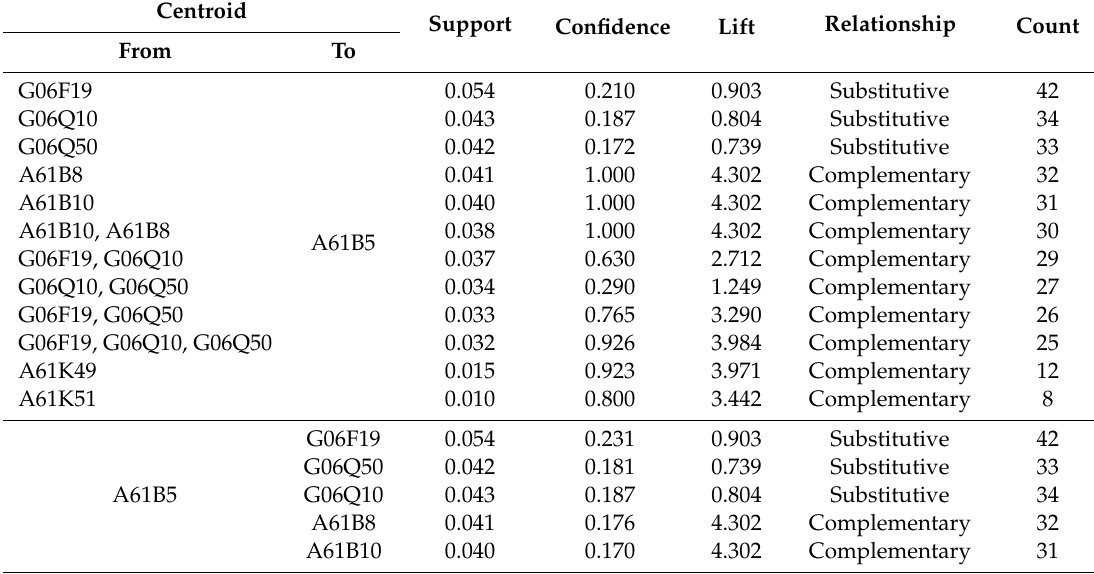
Table A1. Relationships of clusters in the science-based pharmaceutical innovation period (2000–2007).